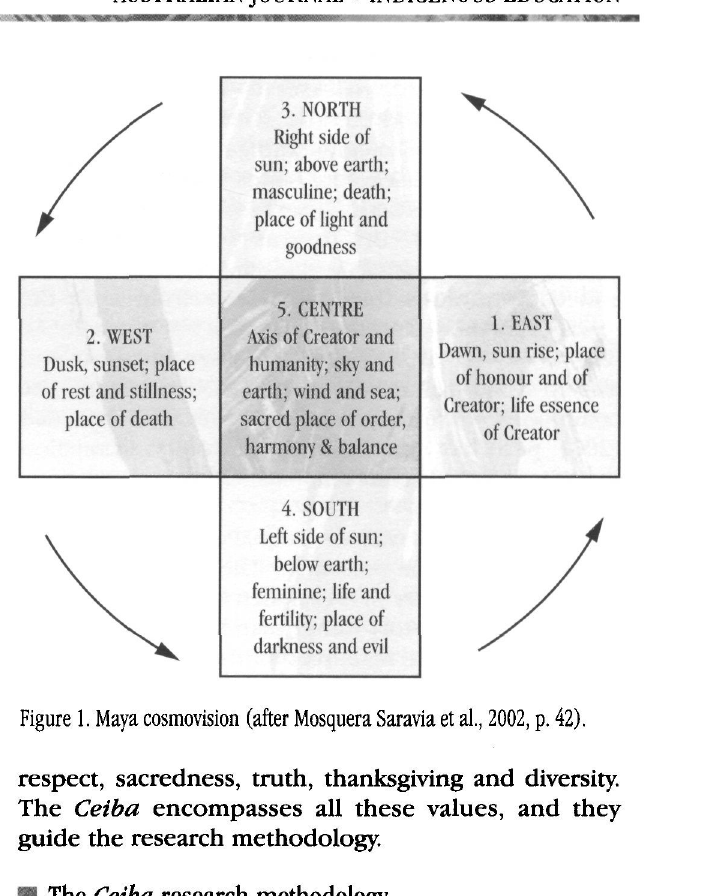
Figure 1. Maya cosmovision (after Mosquera Saravia et al., 2002, p. 42). respect, sacredness, truth, thanksgiving and